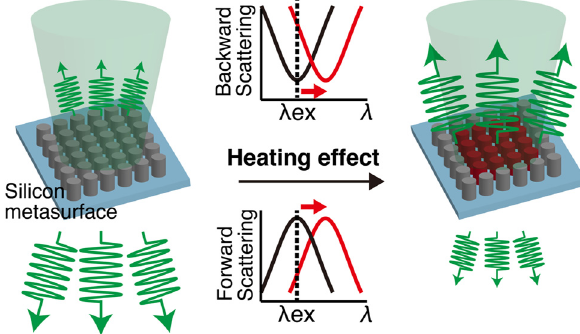
Figure 1: Mechanism on photothermal control of scattering directionality from silicon metasurface. The green cone is the incident beam, and the green arrows represent scattering light. Under resonant excitation, the quasi-perfect absorber metasurface is efficiently heated up by photothermal effect, and subsequent thermo-optical effect results in spectral red-shift, thus changing scattering